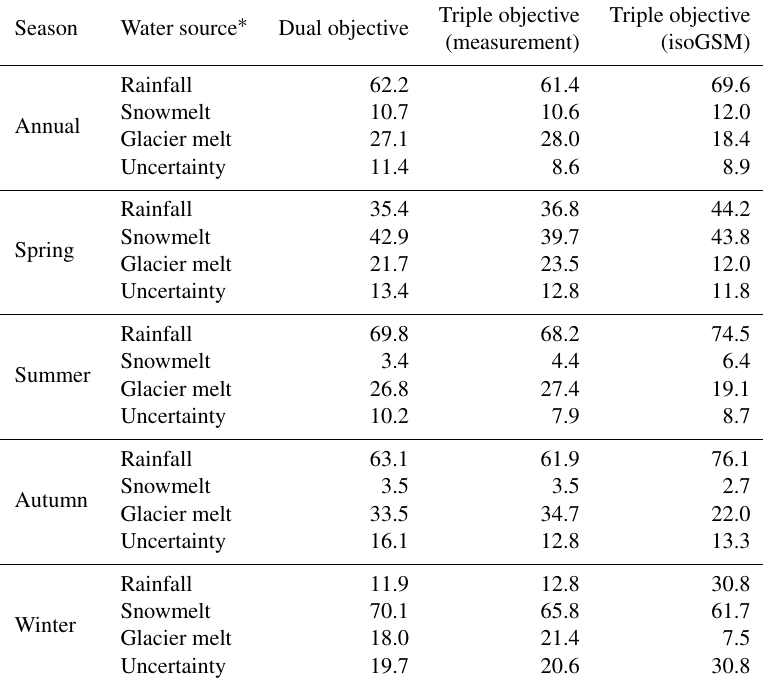
Table 5. Average proportions of water sources in the annual and seasonal water inputs for runoff generation in the YTR